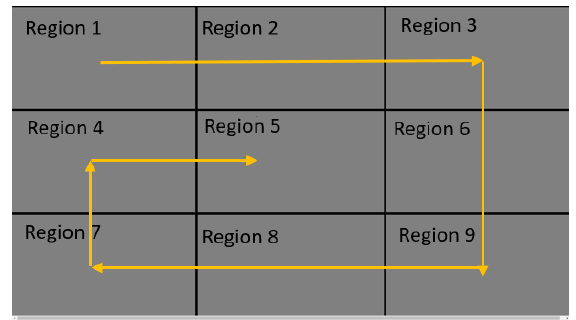
Figure 4. Region annotations for 9 blocks on